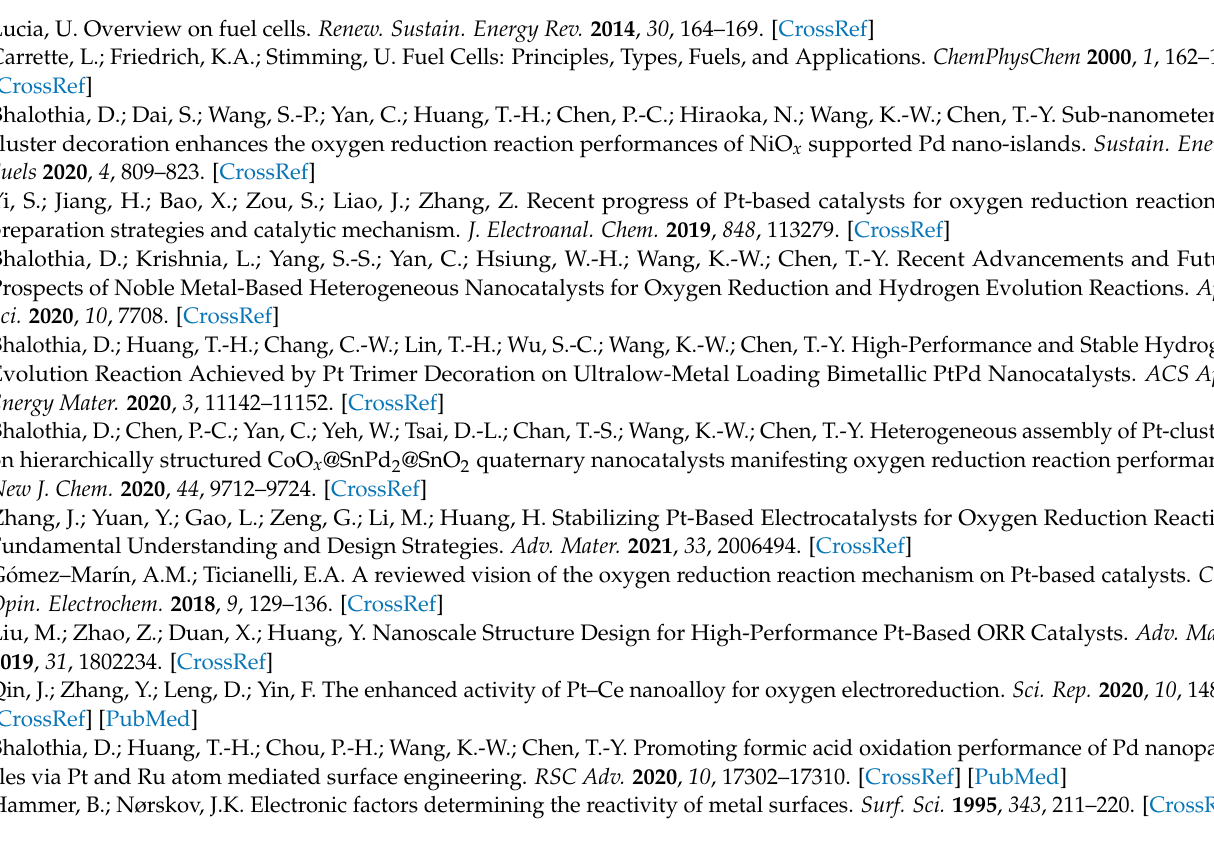
Figure S3: Electrochemical results of CSPP NCs compared with CSP NC. (a) CV and (b) LSV curves of CSPP-RT, CSPP-50 and CSPP-75 NCs compared with reference sample (CSP). (c) Onset potential (Voc)/half wave potential (E1/2) and (d) ORR mass activity of CSPP NCs compared with commercial J.M.-Pt/C NCs; Table S1: The ICP-OES determined actual composition of CSPP NCs; Table S2: XRD determined average particle size of experimental NCs; Table S3: Electrochemical parameters of experimental